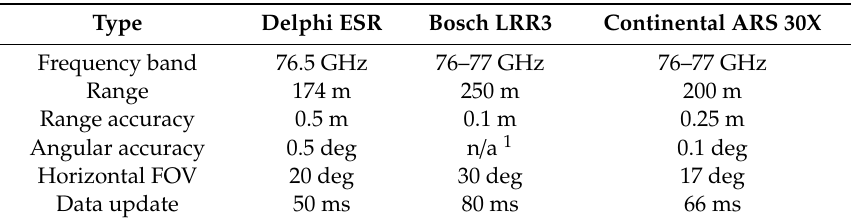
Table 1. Automotive radar specifications.